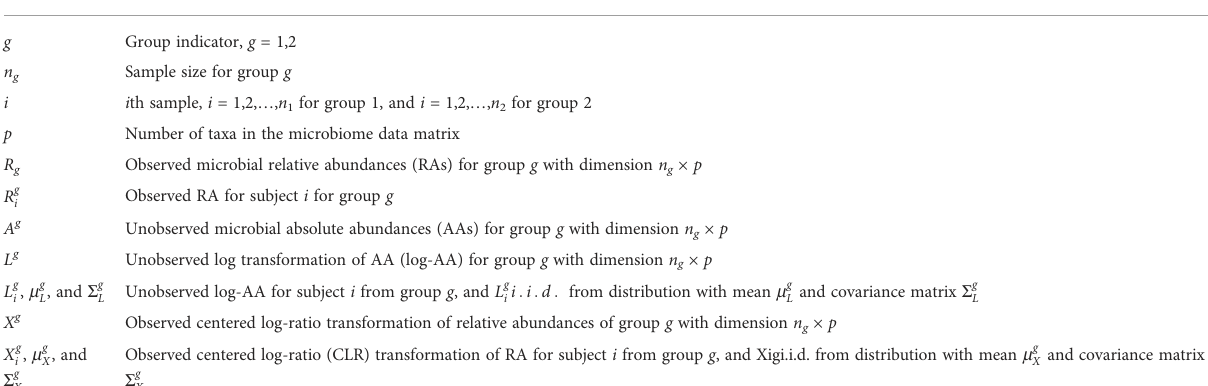
TABLE 2 Notation